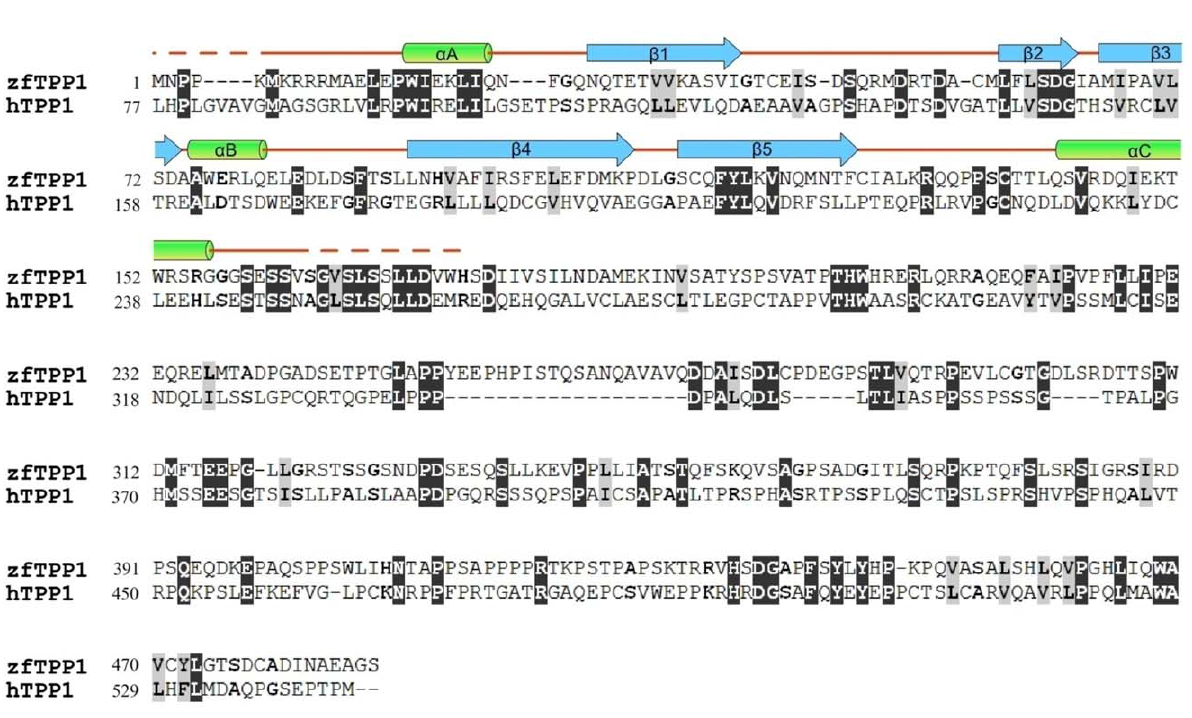
Figure 1. Sequence alignment of zebrafish TPP1 (zfTPP1) and human TPP1 (hTPP1). Alignment was carried out by ClustalW. The conserved residues are in shaded black and gray. The alpha helices (cylinders) and beta strands (arrows) of the hTPP1 OB-folds are illustrated above the aligned sequences. doi:10.1371/journal.pone.0016440.g001 PLoS ONE |